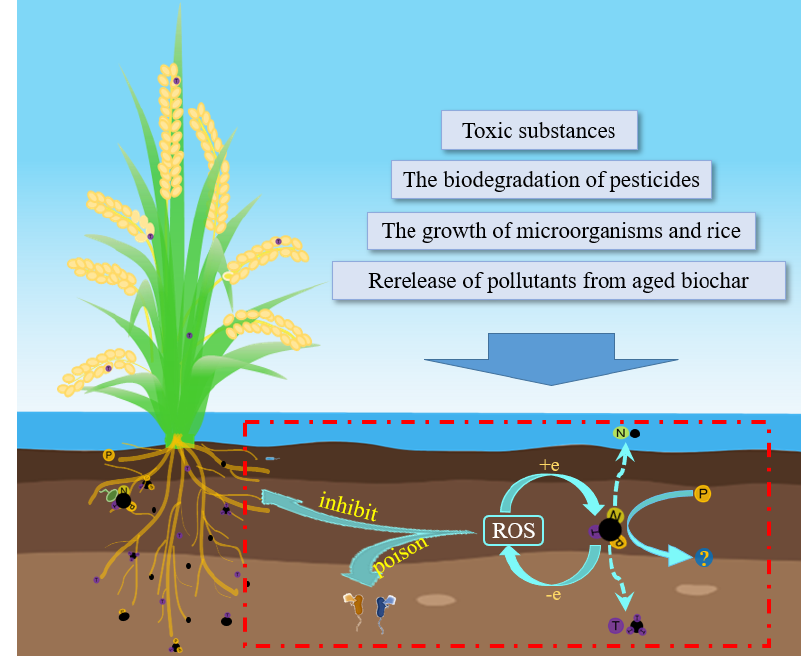
Figure 3. Potential risks of BC application in paddy fields.